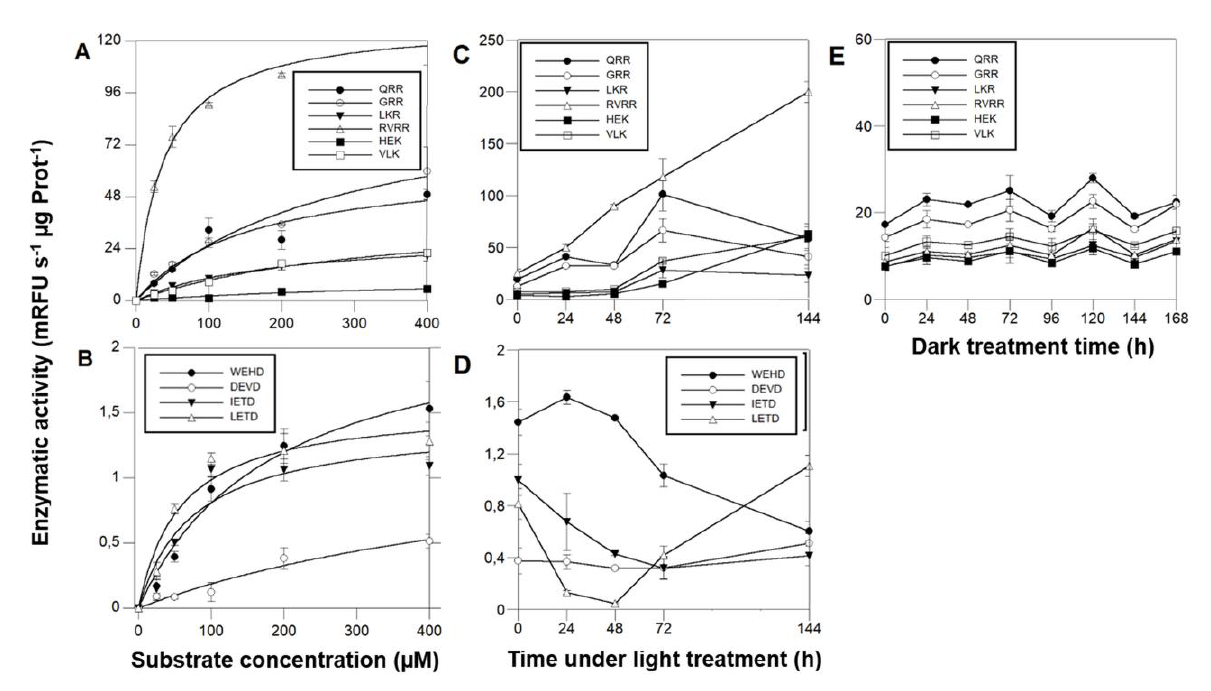
FIGURE 5. MCs and CL enzymatic activities in D. tertiolecta exposed to PAR + UVA + UVB (PAB) for six days. Michaelis-Menten kinetics showed by Boc-7-amino-4-fluoromethyl coumarin (AMC) reporters of the substrates RVRR ( △ ), QRR ( ● ), GRR ( ○ ), LKR ( ▼ ), HEK ( ■ ), and VLK ( □ ) (A) ; Michaelis-Menten kinetics showed by Ac-7-amino-4-trifluoromethyl coumarin (AFC) reporters of the substrates WEHD ( ● ), DEVD ( ○ ), IETD ( ▼ ), and LEHD ( △ ) (B) ; Cleavage activity showed by D. tertiolecta under PAB of (AMC) reporters of the substrates RVRR ( △ ), QRR ( ● ), GRR ( ○ ), LKR ( ▼ ), HEK ( ■ ), and VLK ( □ ) (C) ; Cleavage activity showed by D. tertiolecta under PAB of (AFC) reporters of the substrates WEHD ( ● ), DEVD ( ○ ), IETD ( ▼ ), and LETD ( △ ) (D) ; Cleavage activity showed by D. tertiolecta during dark-induced CD of (AMC) reporters of the sub- strates with R in P1 (E) , symbols as in (A) . Symbols are means of measurements of two independent replicate cultures and three replicate samples from each culture cylinder. Error bars indicate standard